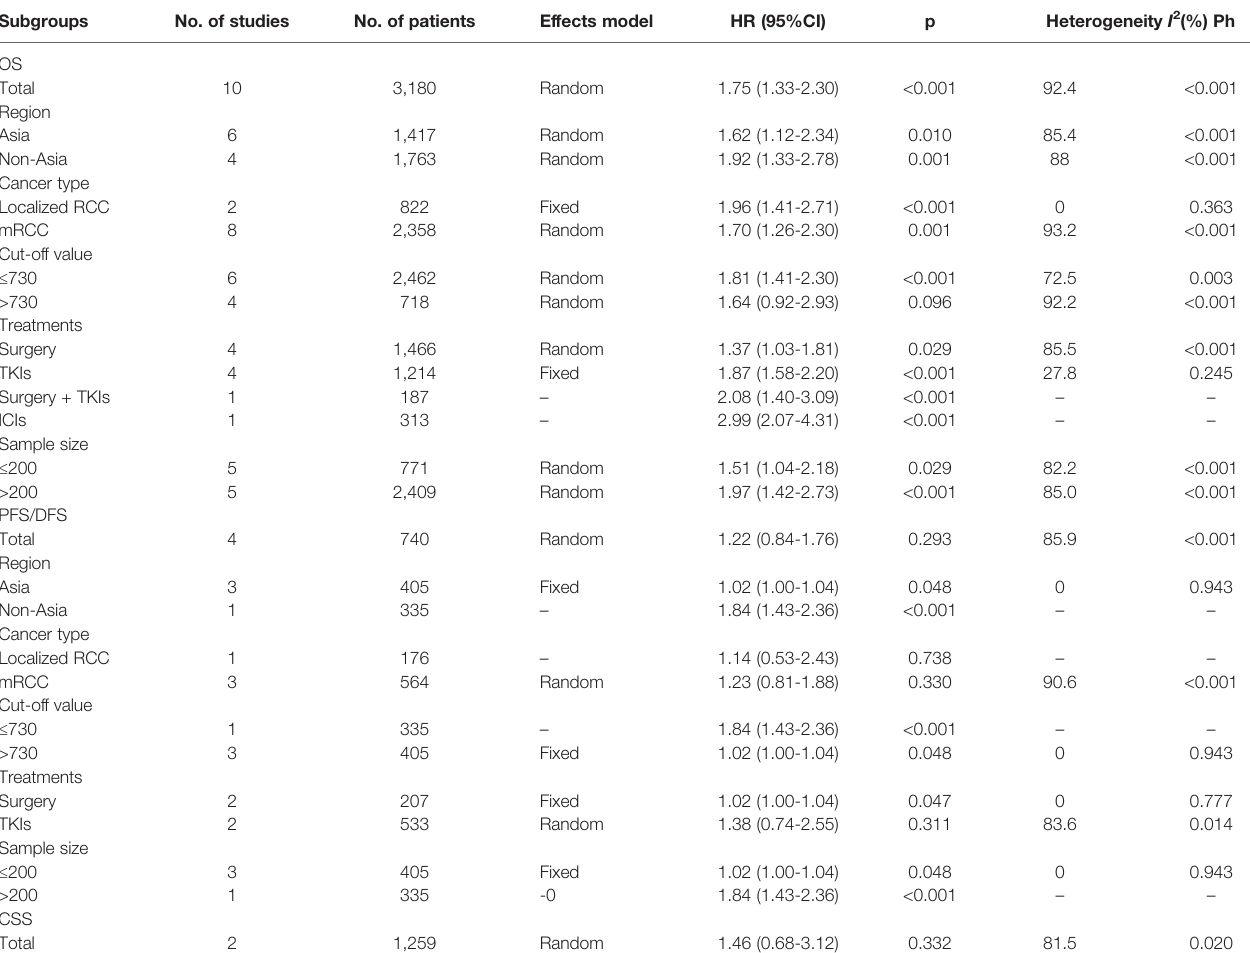
TABLE 2 | Subgroup analyses of SII for prognosis in patients with RCC. Subgroups No. of studies